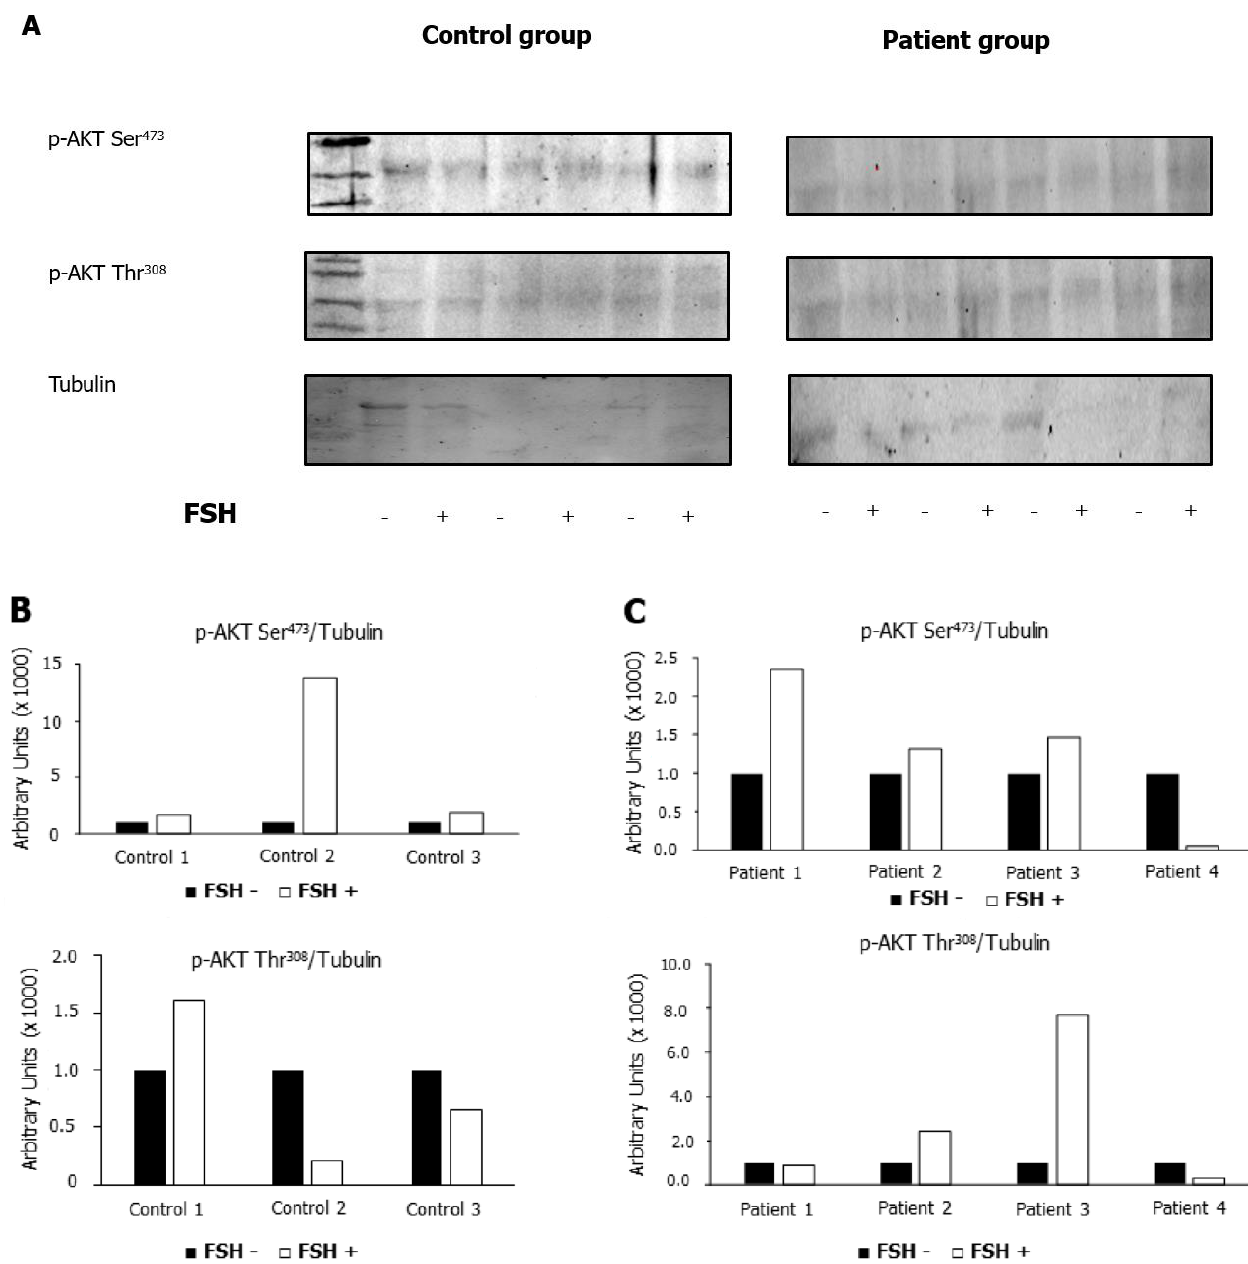
Figure 5. Phosphorylation of protein kinase B (AKT) in Serine 473 and Threonine 308. Immunoblots ( A ) and densitometric analysis ( B , C ) of p-AKT Ser 473 /tubulin ratio and p-AKT Thr 308 /tubulin ratio in patients and controls. p-AKT Ser 473 /Tubulin increased after incubation with hpFSH in most of the patients and controls. p-AKT Ser 308 /tubulin ratio increased in a minority of patients and controls.